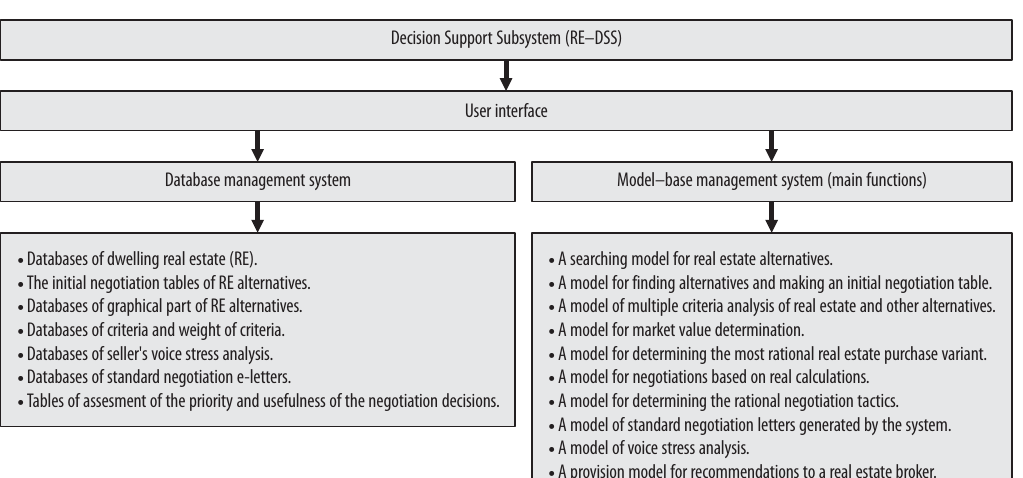
Figure 1. The components of Decision Support